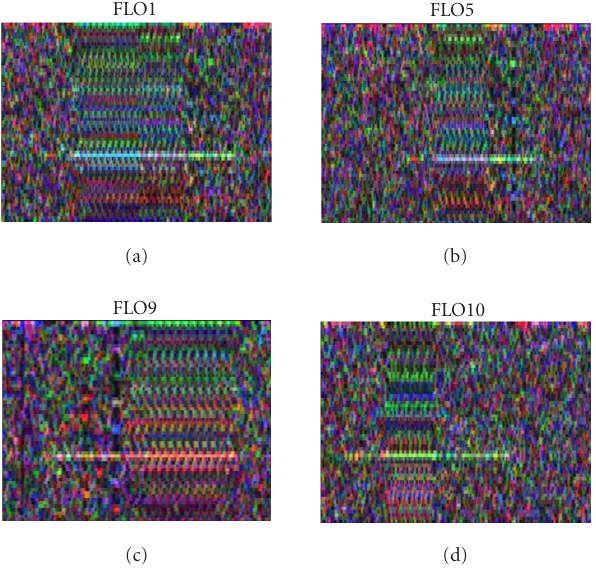
Figure 19: Four spectrograms of FLO genes 1, 5, 9, and 10. Quilts can be seen in all four genes. Close inspection of (a) and (b) shows that (b) is a subsection of (a). FLO9 (c) shows the same coloration as the other three upon reverse